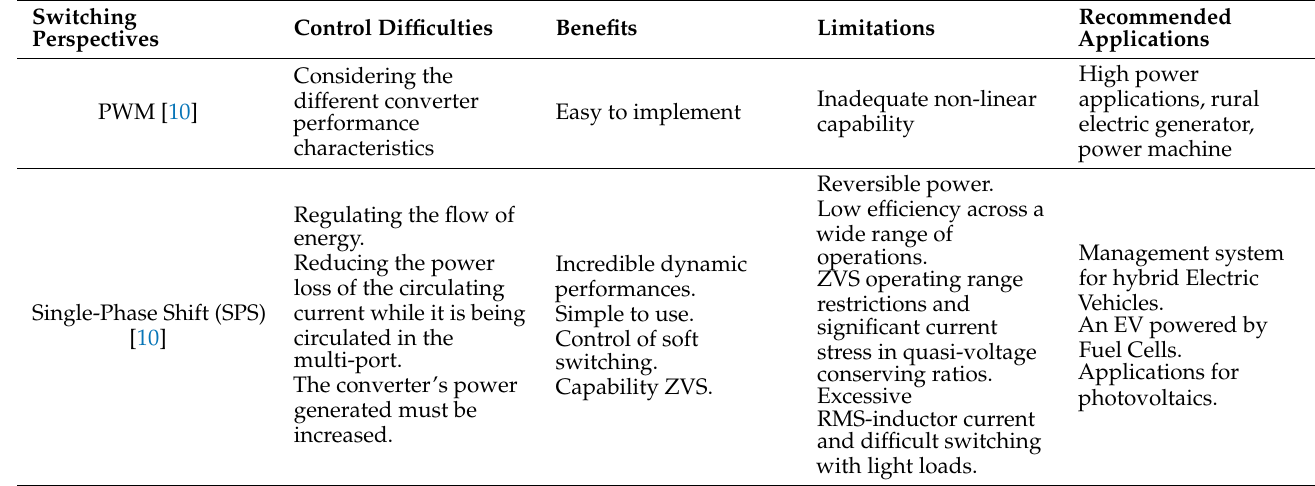
Table 5. An overview of bidirectional (DC-DC) converter switching strategies.